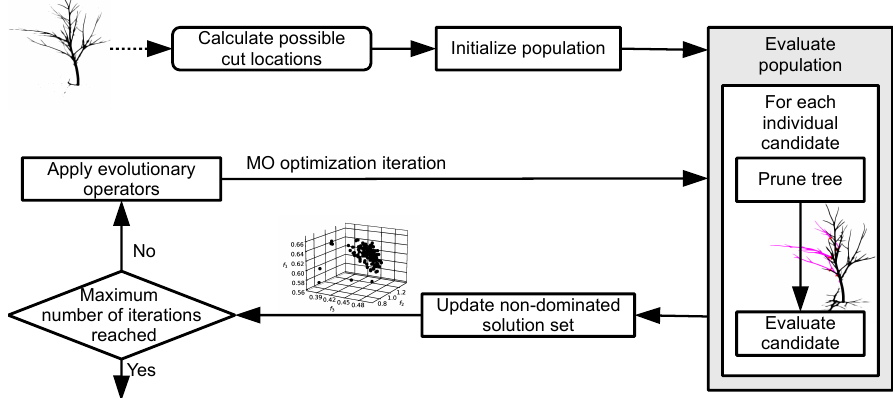
Figure 4. Block diagram of the proposed multi-objective pruning optimization method. Algorithm 1 Multi-objective pruning